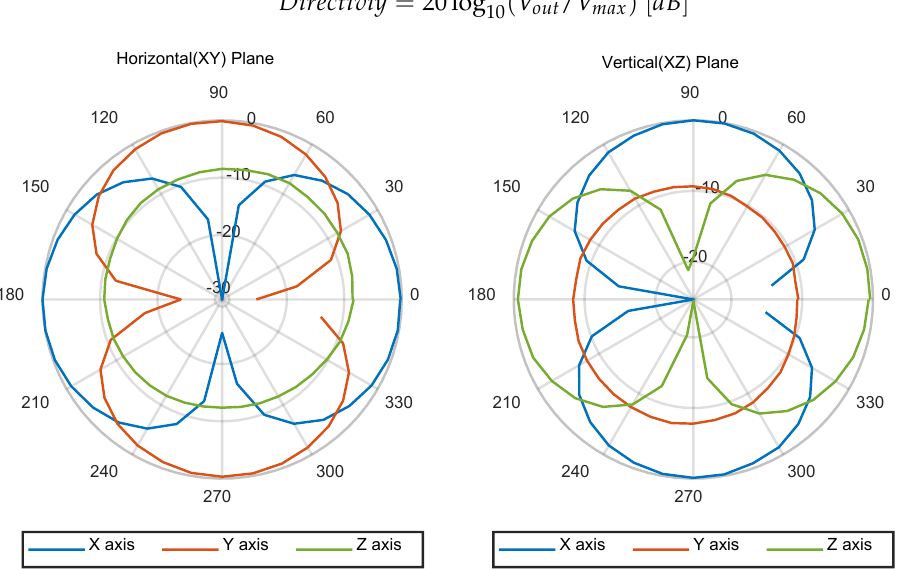
Figure 9. Measured directivities obtained from the goniometer experiment in air.